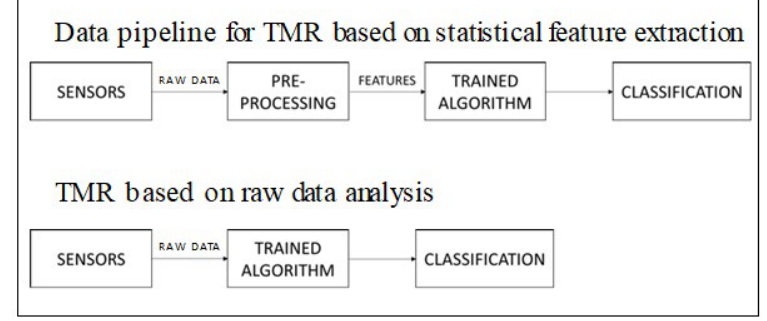
Figure 4. Functional flows for Transportation Mode Recognition (TMR).